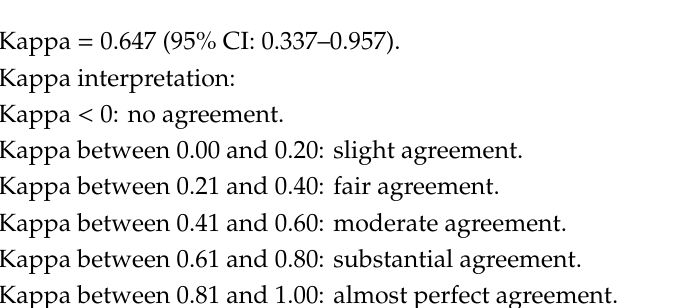
Number of observed agreements: 20 (83.33% of the observations).